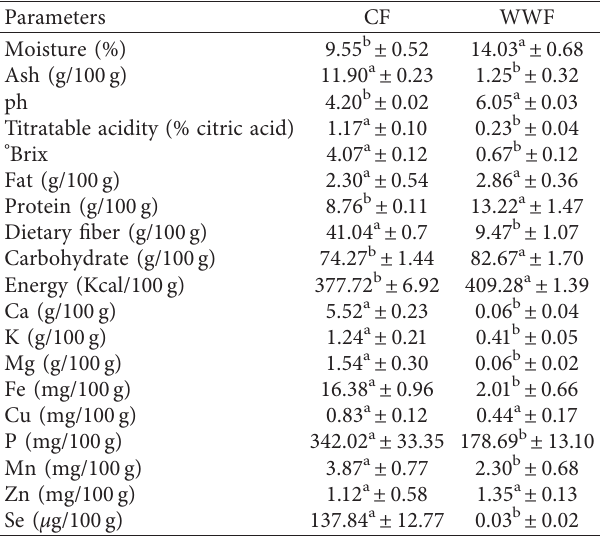
Table 1: Proximate composition of cladode flour and whole-wheat